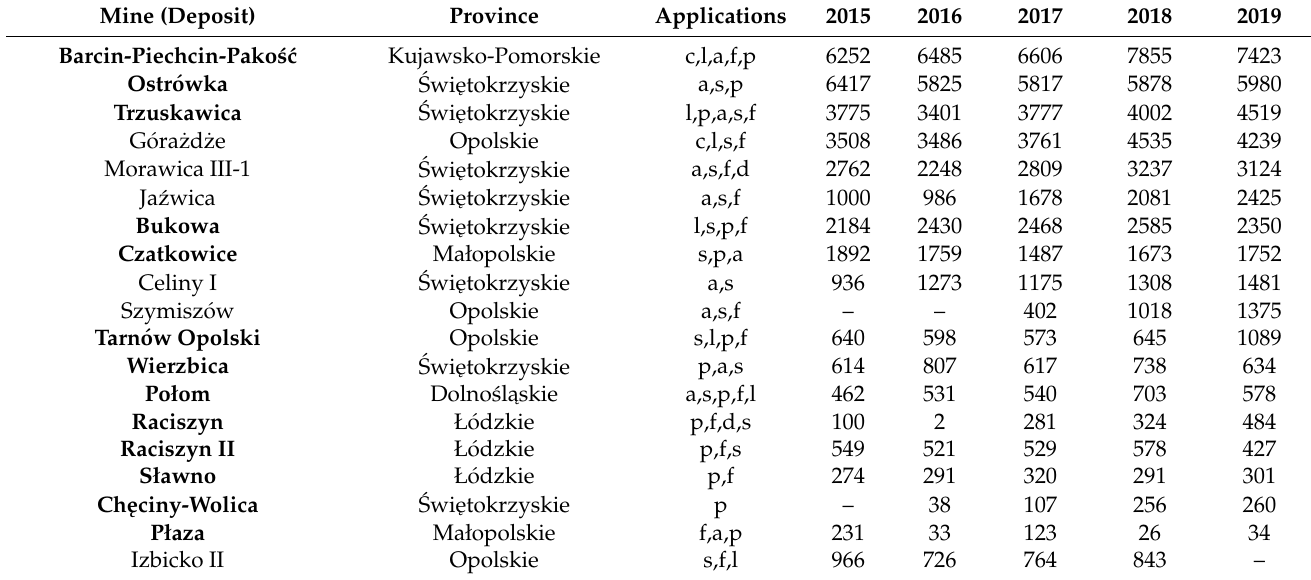
Table 1. Mining production of limestone in major mines, delivering industrial limestones as the main or additional products (kt) 1